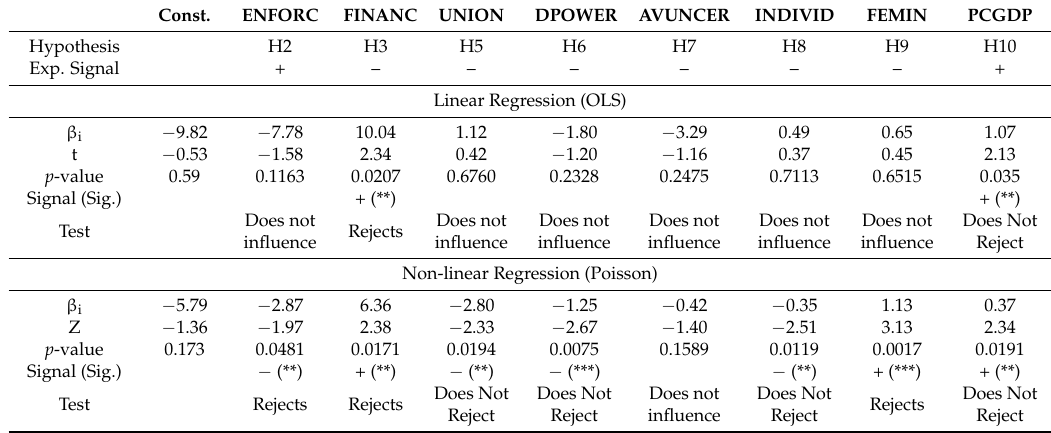
Table 4. Regression